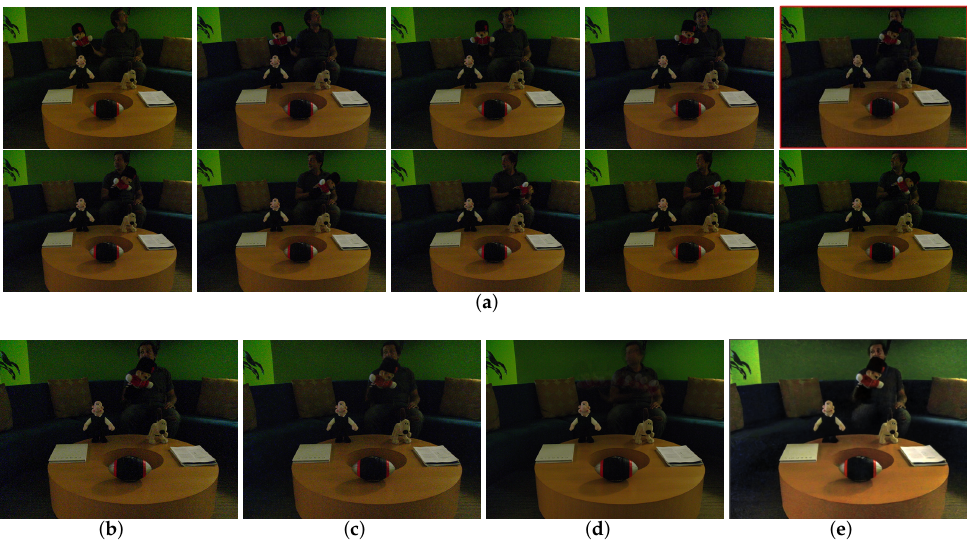
Figure 7. Image fusion for denoising. ( a ) Input images. ( b ) Reference input. ( c ) Sen [5]. ( d ) Li12 [35]. ( e )